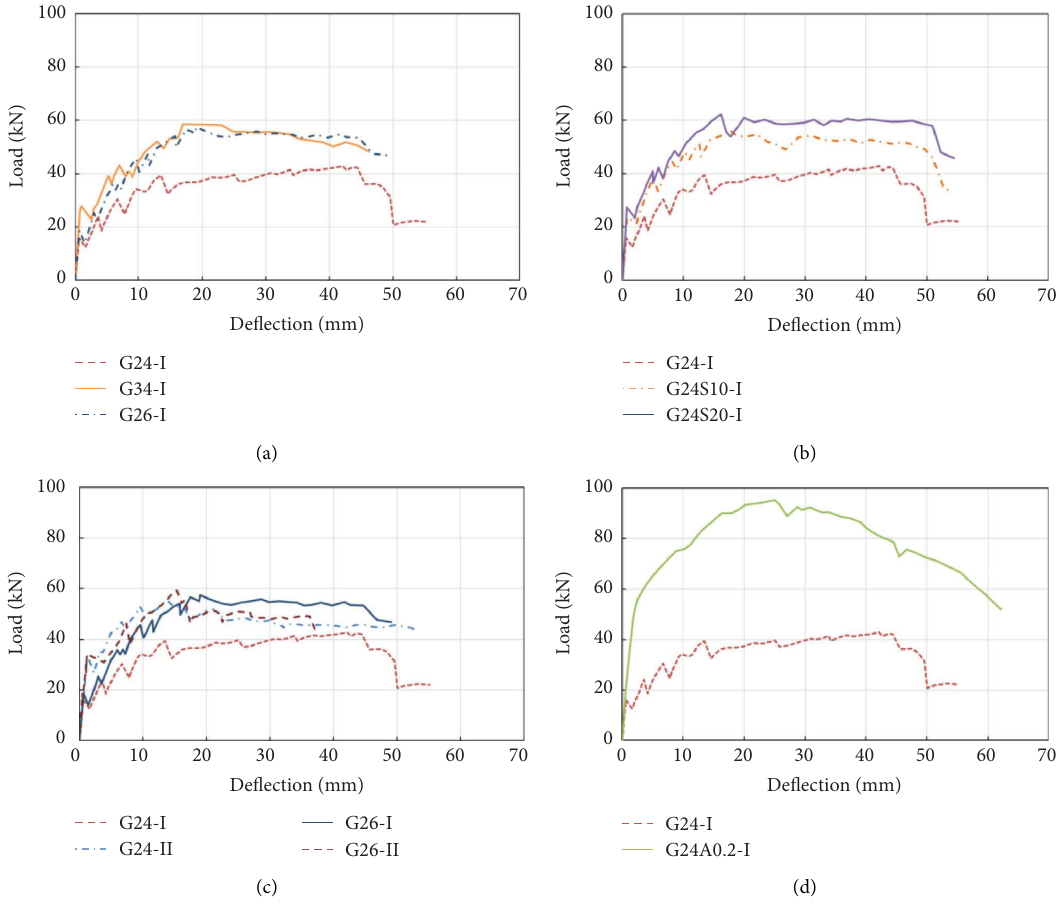
Figure 7: Load-defection curves. (a) Specimens with diferent thicknesses of FRP jacket and dumbbell. (b) Specimens with diferent